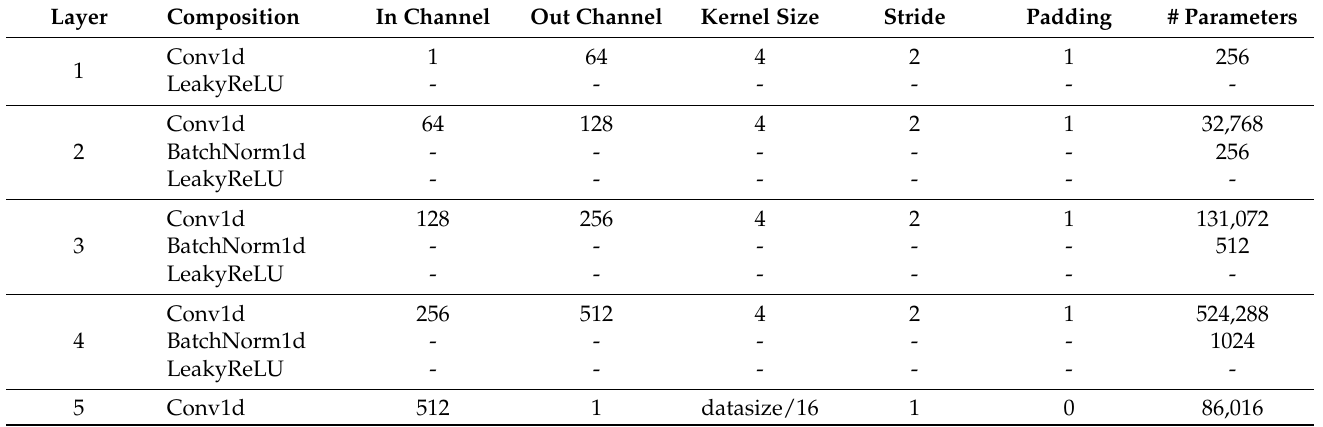
Table 1. Network layer structure of discriminator in GAN used for the proposed system.